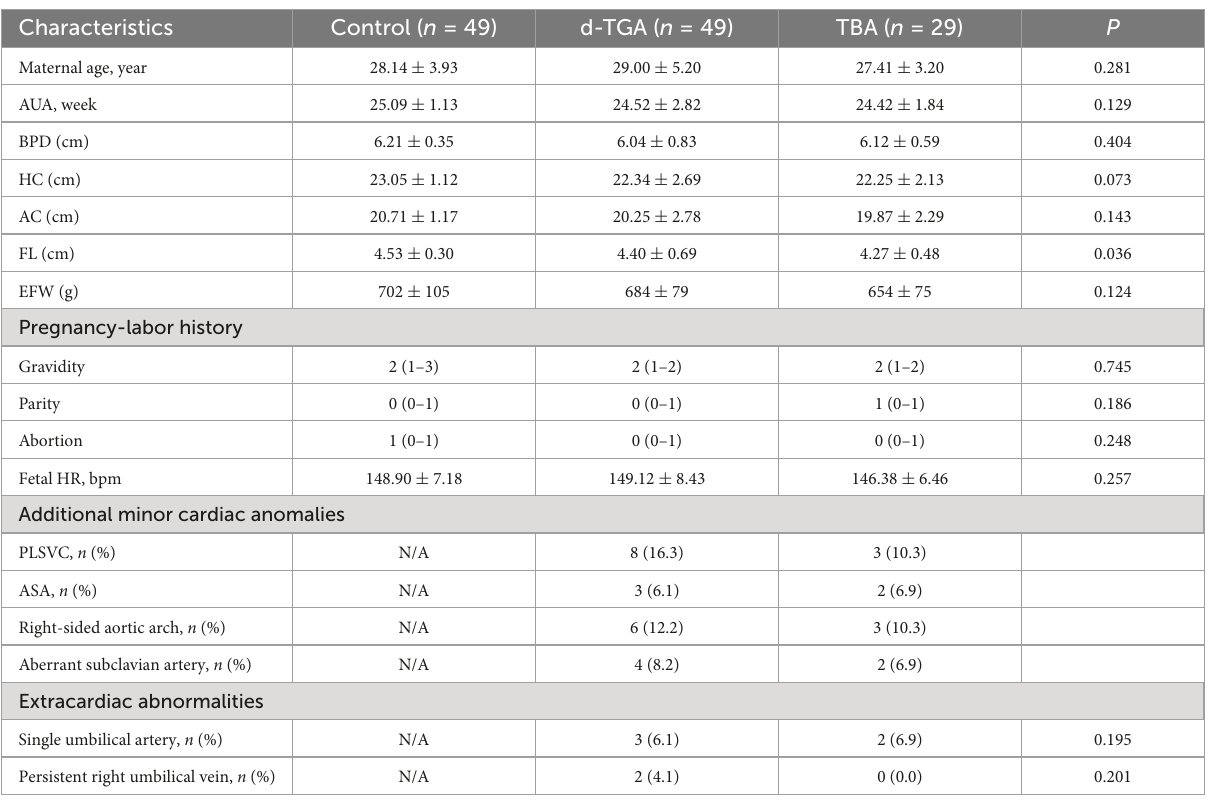
TABLE 1 Baseline characteristics of the fetal study